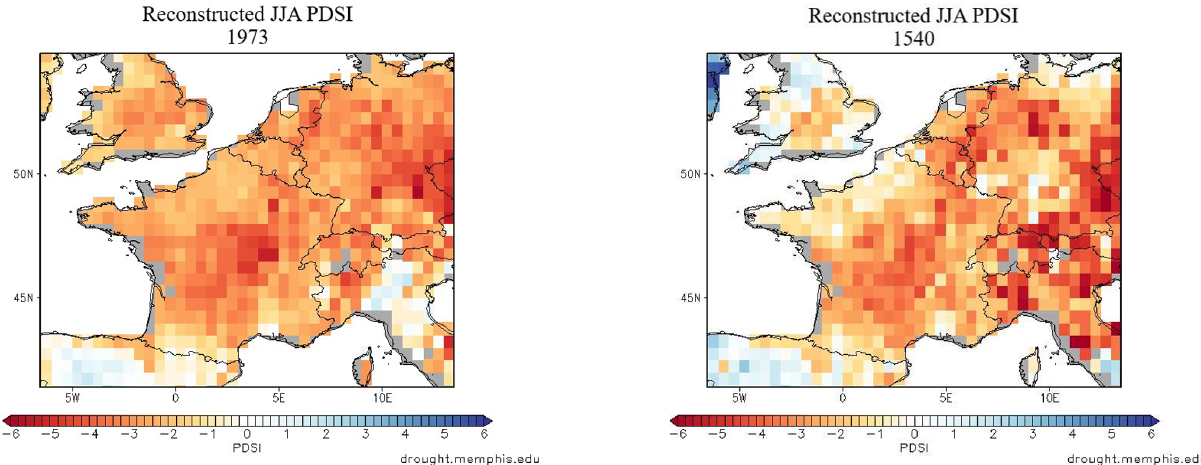
Figure 4. (a) Map of the year 1473 from the OWDA. (b) Map of the year 1540 from the OWDA (Cook et al.,